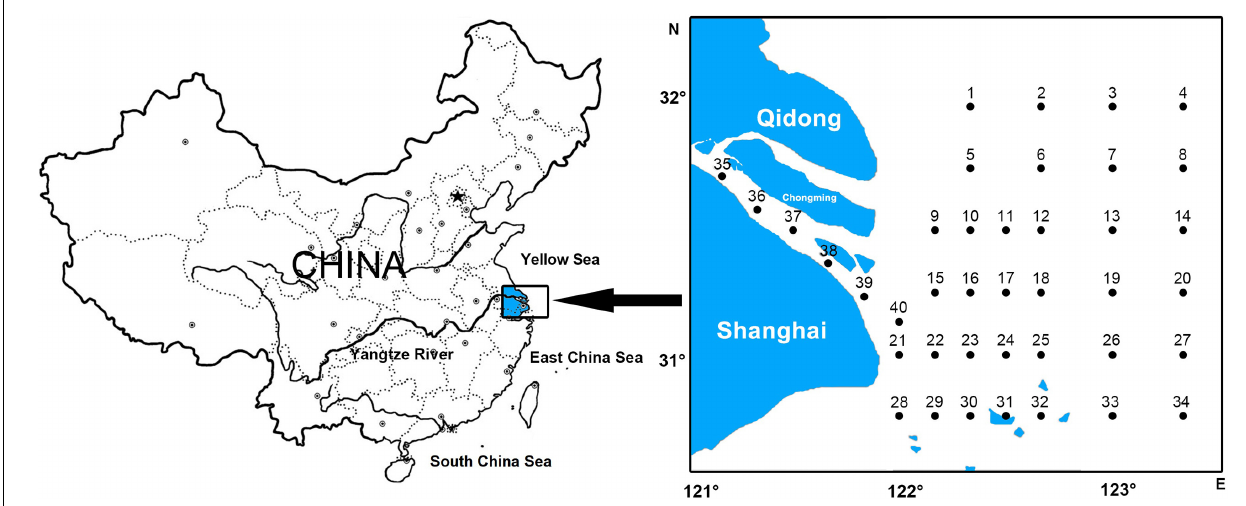
FIGURE 1 | Location of study area and sampling stations in the Yangtze Estuary from 2013 to